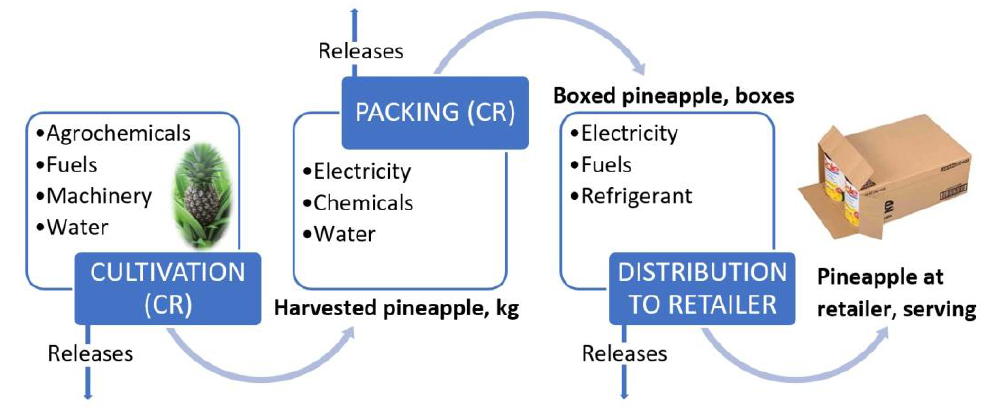
Figure 2. Diagram of fresh pineapple system [5].